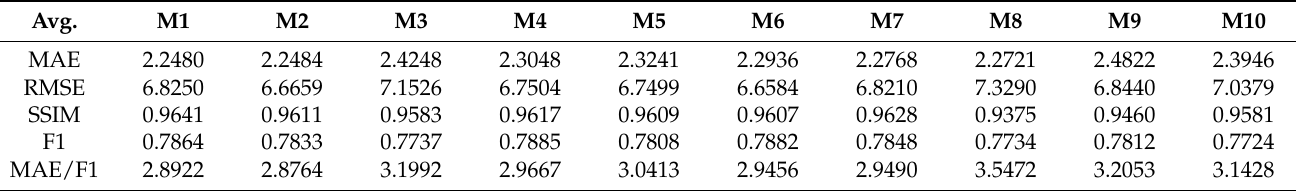
Table 5. Statistical comparisons according to the combinations of input